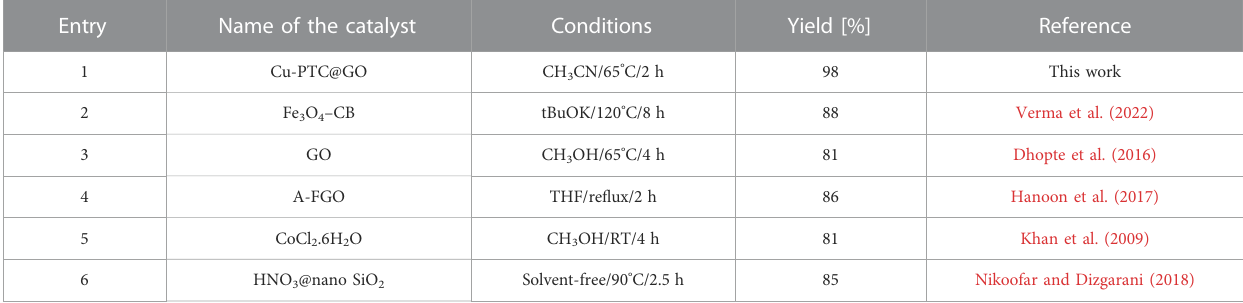
TABLE 3 Comparison catalytic activity of Cu-PTC@GO with similar